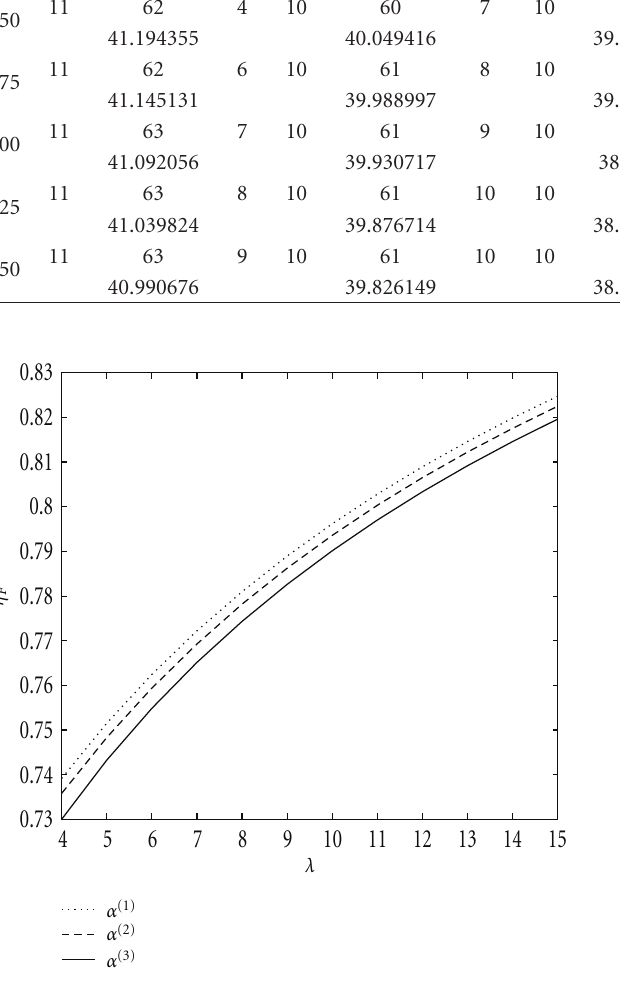
Figure 2: Fraction of time server is on vacation— λ versus α ( n ) ( S = 90, s = 15, N = 25, β = 1 . 4, γ = 4, μ = 0 . 8, p = 0 . 75 . )